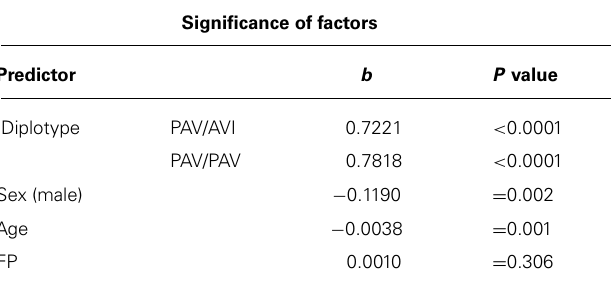
Table 1 | FP density is not predictive of PROP intensity